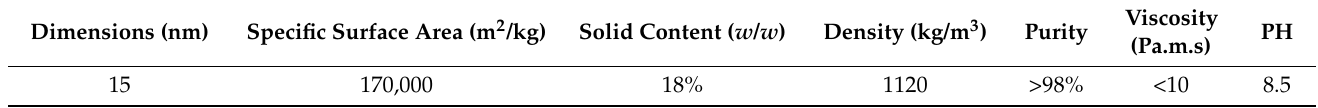
Table 2. Physical and chemical properties of consumed nano-silica.